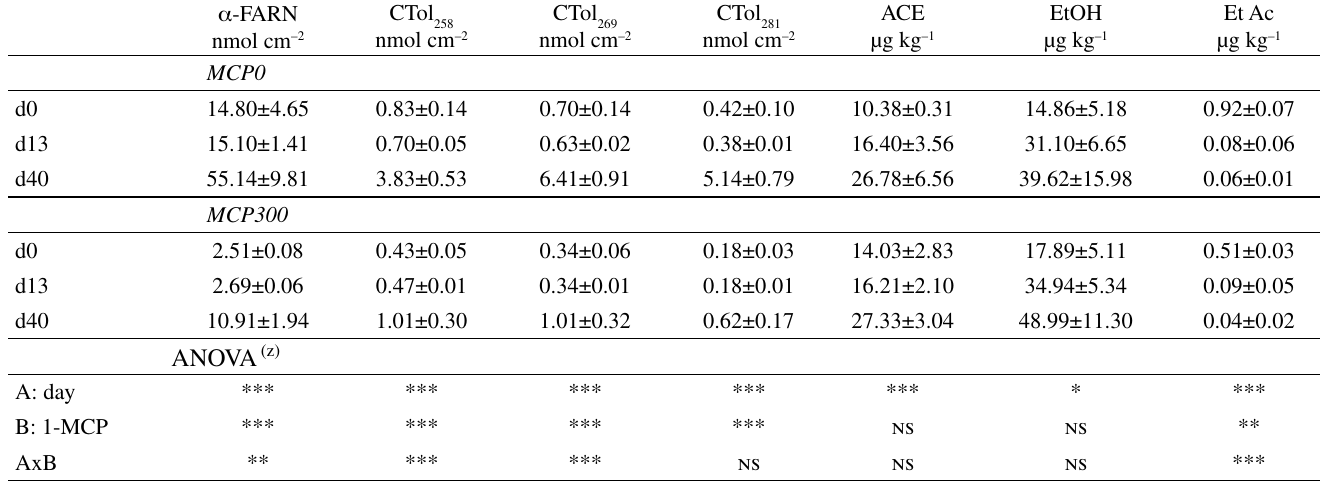
Table 2 - Amounts (mean ± standard error) of α -farnesene ( α -FARN), CTols (CTol dehyde; EtOH, ethanol; EtAc, ethyl acetate) in control (MCP0) and 1-MCP treated (MCP300) ‘Abbé Fétel’ pears at the beginning (d0) and at the end (d13) of the second ILOS period and in correspondence with the first storage time (d40) and ANOVA results